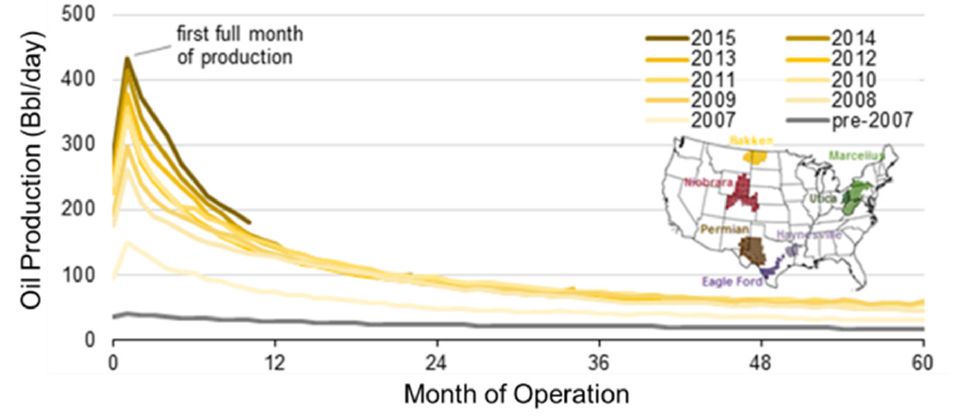
Figure 1. Average oil production per well in the Bakken Formation, Williston Basin, North Dakota [10].